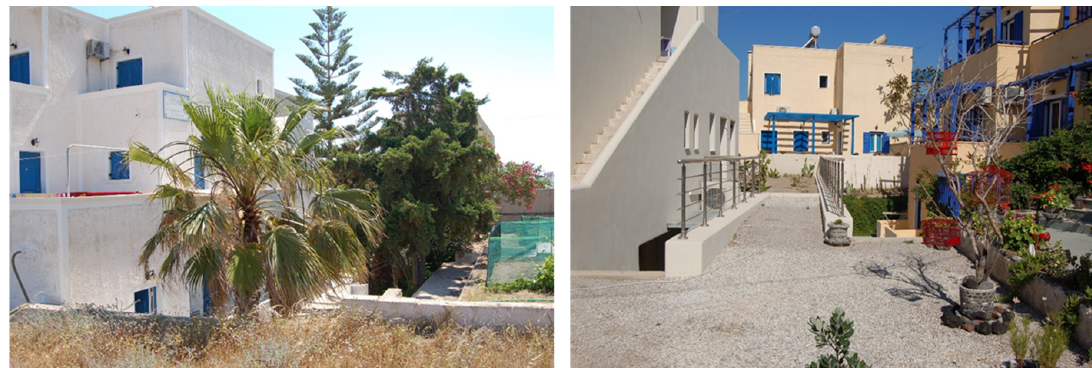
Figure 9. Buildings with basements found in the south ( left ) and central ( right ) part of Kamari.